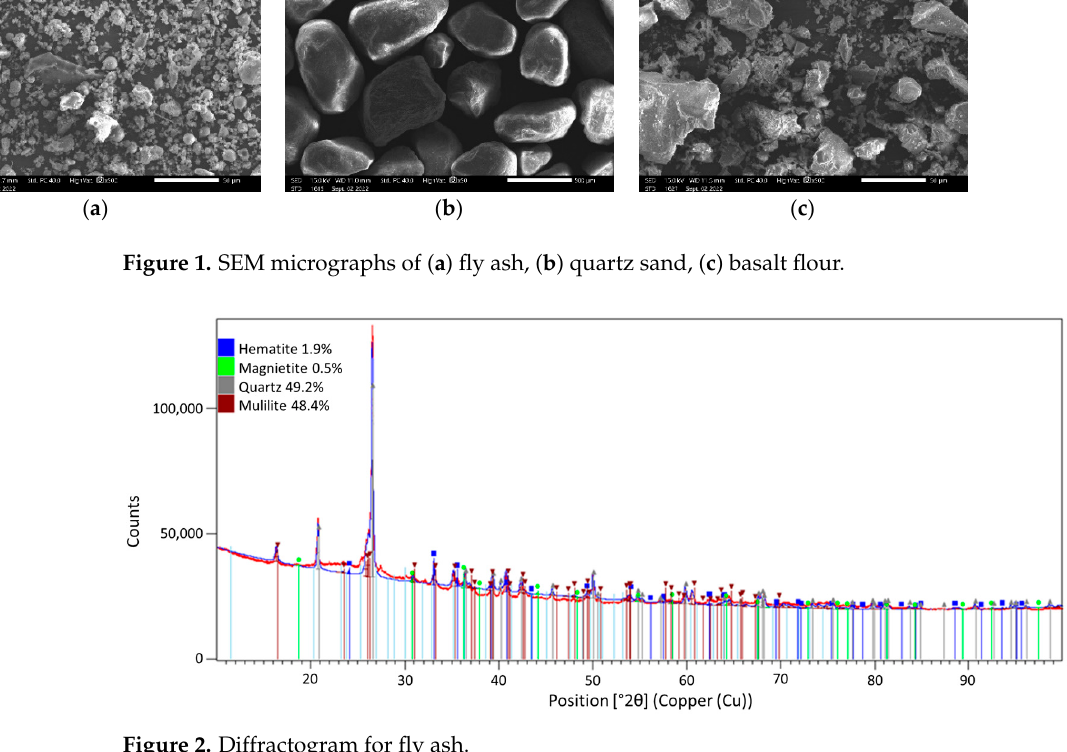
Figure 2. Diffractogram for fly ash.